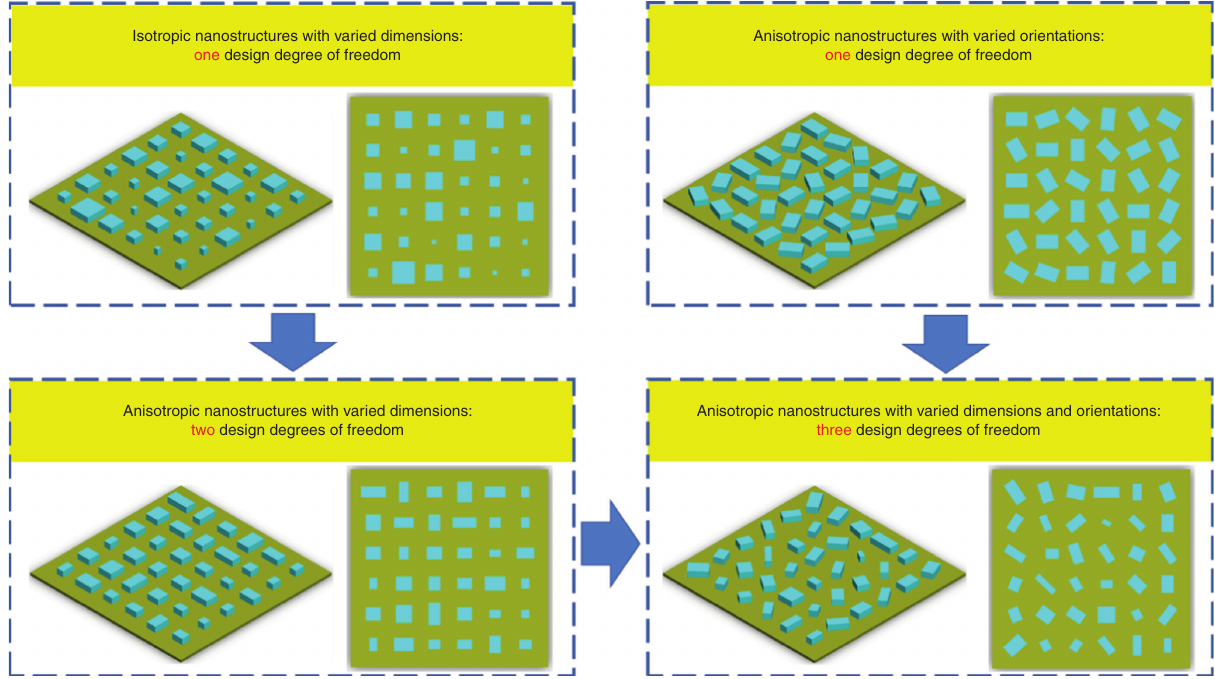
Figure 1: Schematic of the degrees of freedom in nanostructured metasurface design: from 1 to 3. More design degrees of freedom can be acquired with multilayered (stacked) and dynamic